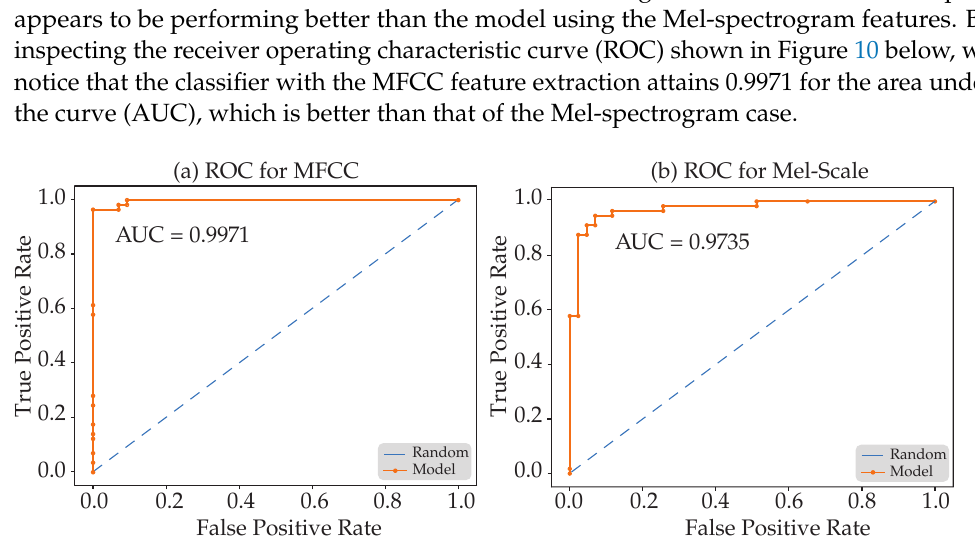
Figure 10. ROC curves for ( a ) MFCC and ( b ) Mel-spectrogram feature